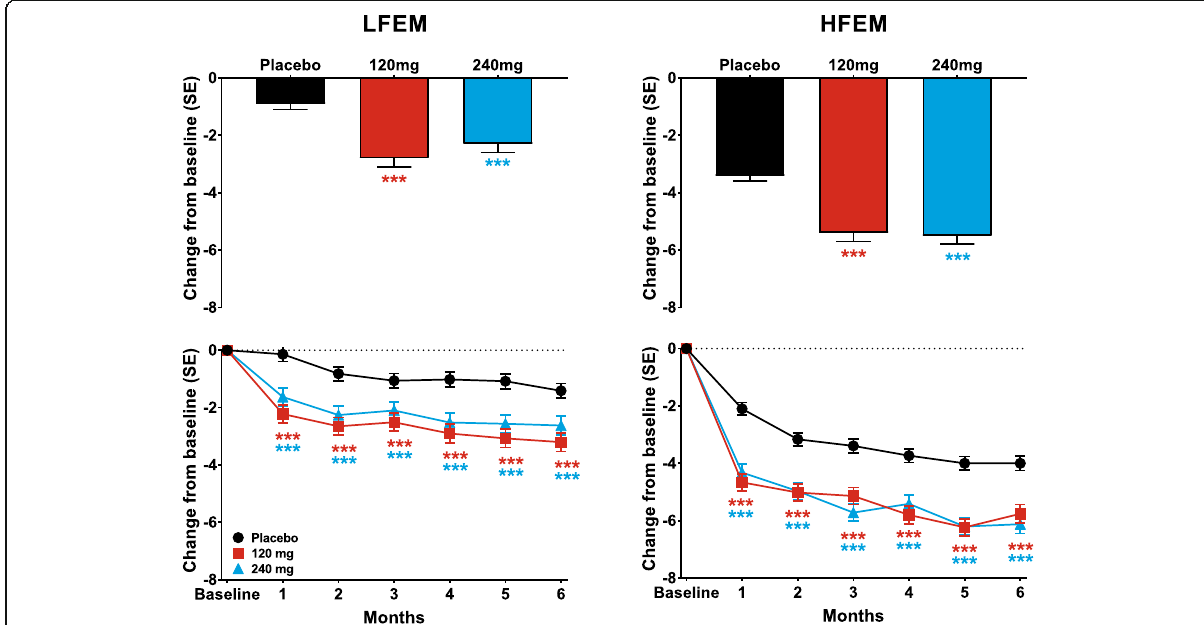
Fig. 1 The overall least-squares (LS) mean change from baseline in monthly MHDs is shown for patients with LFEM and HFEM receiving placebo, 120-mg, or 240-mg of galcanezumab in the upper row. The monthly LS mean changes in monthly MHDs for patients receiving these treatments is shown in the bottom row for patients with LFEM and with HFEM. *** p ≤ .001, ** p ≤ .01, * p ≤ .05 vs